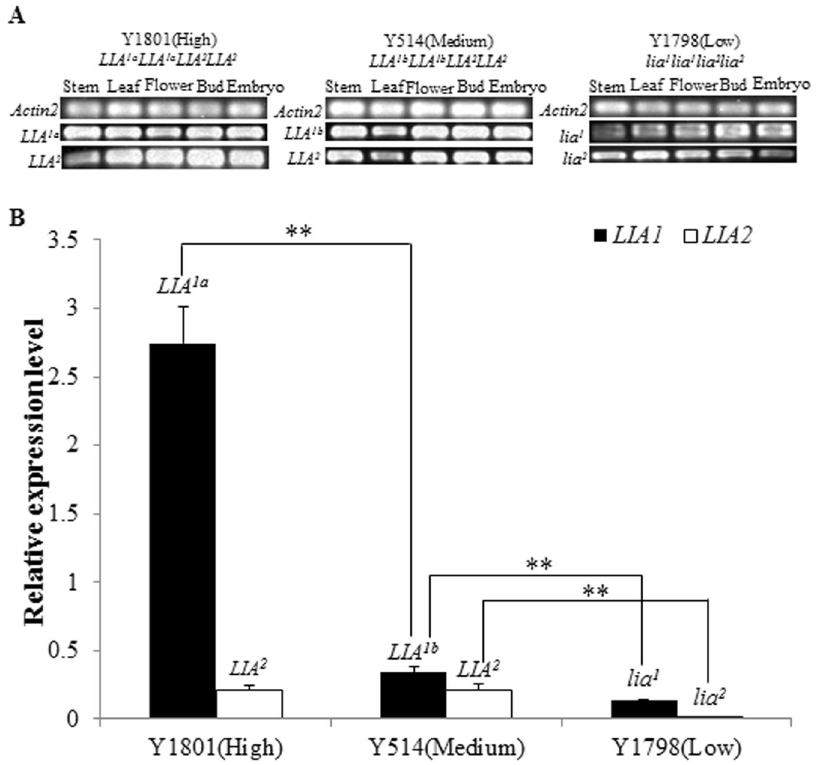
Figure 4. Expression analysis of the SalFAD2 . LIA 1 alleles LIA 1a , LIA 1b and lia 1 , and SalFAD 2. LIA 2 alleles LIA 2 and lia 2 . Actin 2 (FG576123) was used as an internal control. A. LIA 1a , LIA 1b , lia 1 , LIA 2 and lia 2 were expressed in the stem, leaf, flower, bud and 18d old embryo as revealed by RT-PCR. B. Quantitative Real-time PCR analysis of expression levels of the LIA 1a , LIA 1b , lia 1 , LIA 2 and lia 2 in 18d- old embryos of Y1798 (low), Y514 (medium) and Y1801 (high). Error bars indicated SD of the mean. ** Statistical significant difference at p = 0.01